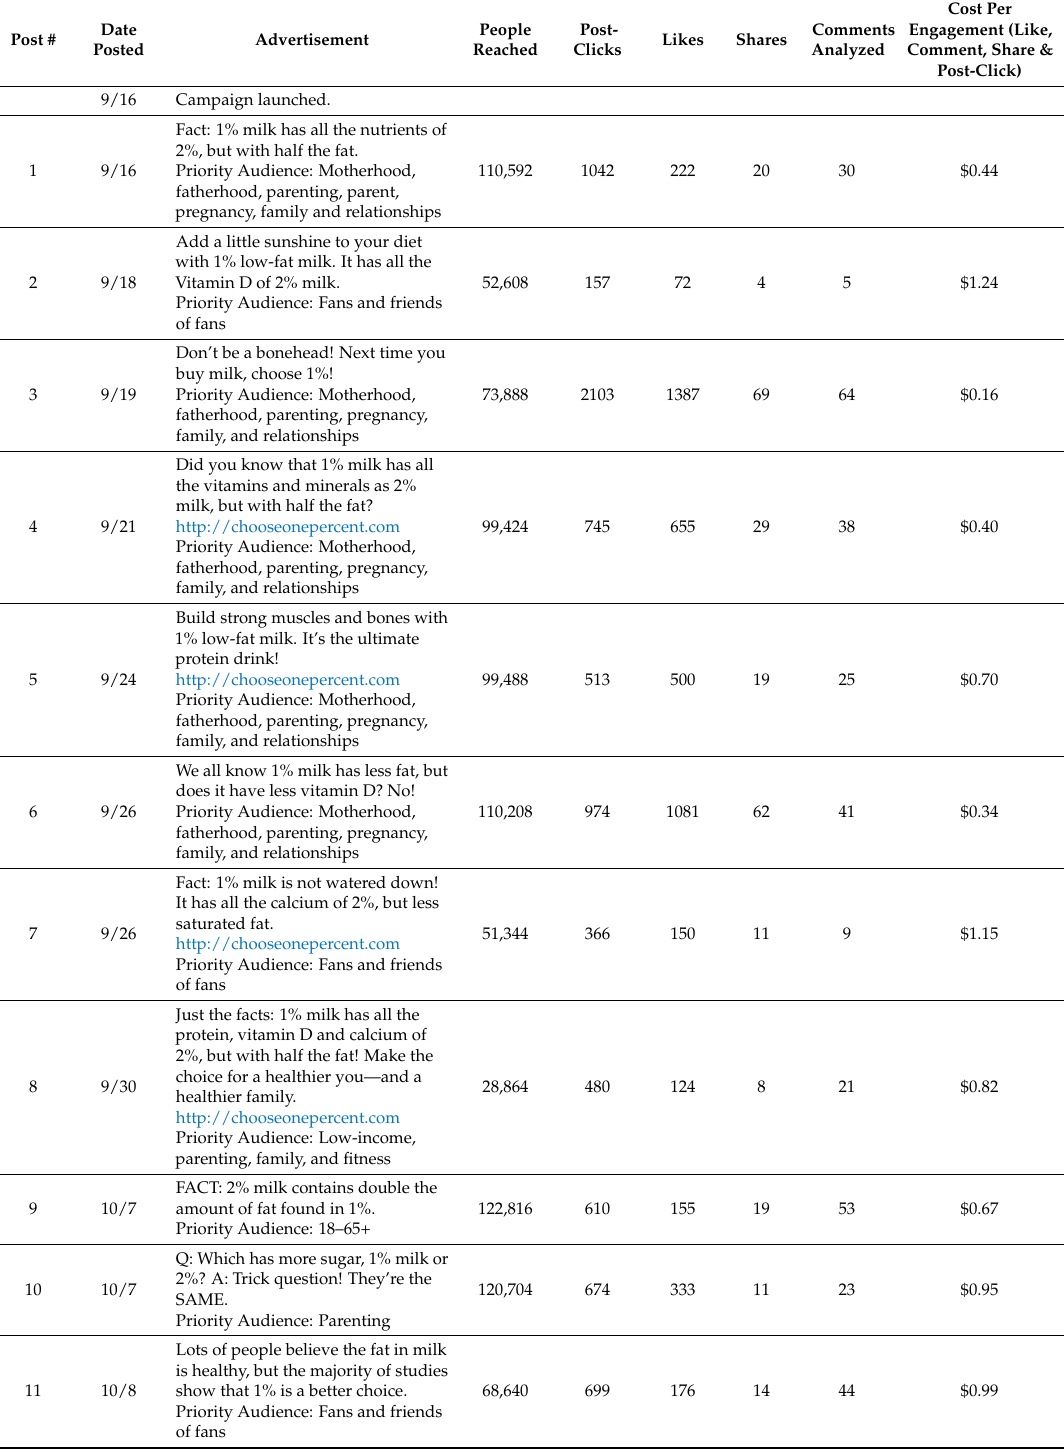
Table 1. Facebook Advertisements and Social Media Participation